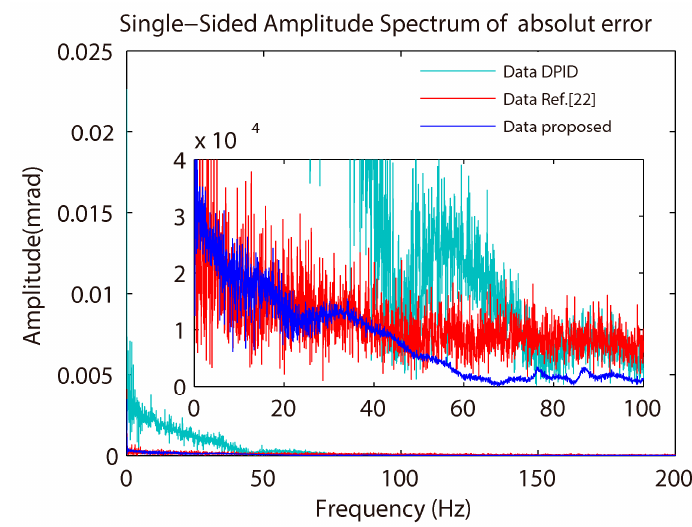
Figure 12. Frequency domain analysis of guidance absolute error curve.